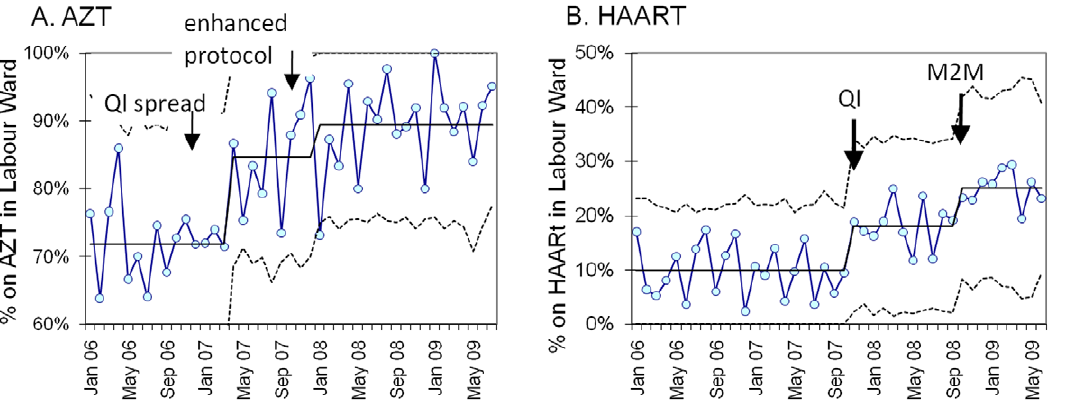
Figure 1. Percentage of HIV + mothers receiving AZT before labour (A); and on HAART at time of delivery (B). Legend: Statistical process control p-charts showing changes (p , 0.001) in mean percentage (with UCL and LCL) of eligible (HIV + ) mothers (A) receiving AZT . 2 weeks before labour (provincial protocol) and (B) on HAART at time of delivery in labour ward (p , 0.001) showing effects of QI spread, protocol change and mother2mothers (M2M) interventions.